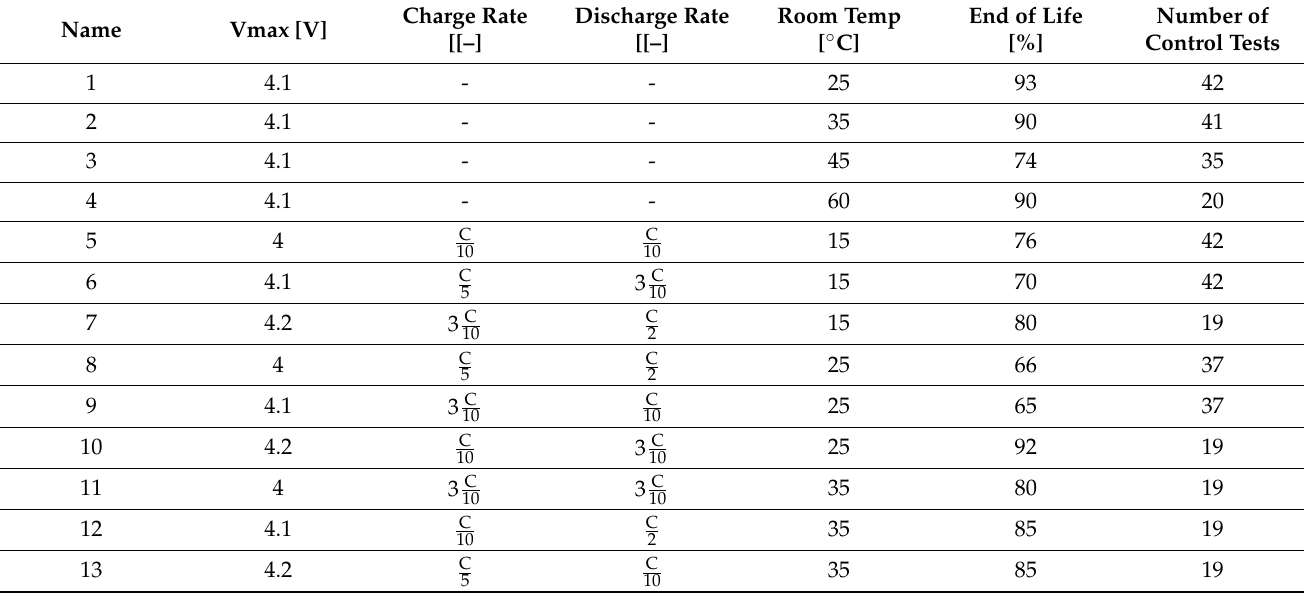
Table 1. Cycling conditions during normal operation for each cell of the